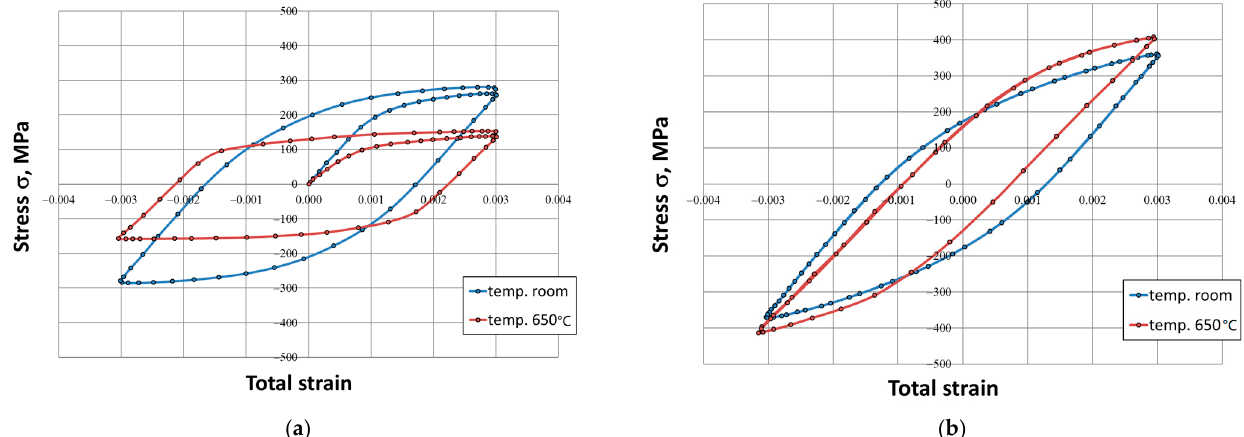
Figure 7. Comparison of the hysteresis loops determined in the low-cycle fatigue test at room temperature and at 650 °C for the strain range ∆ε t = 0.6%: initial state—( a ), saturation state—( b ).